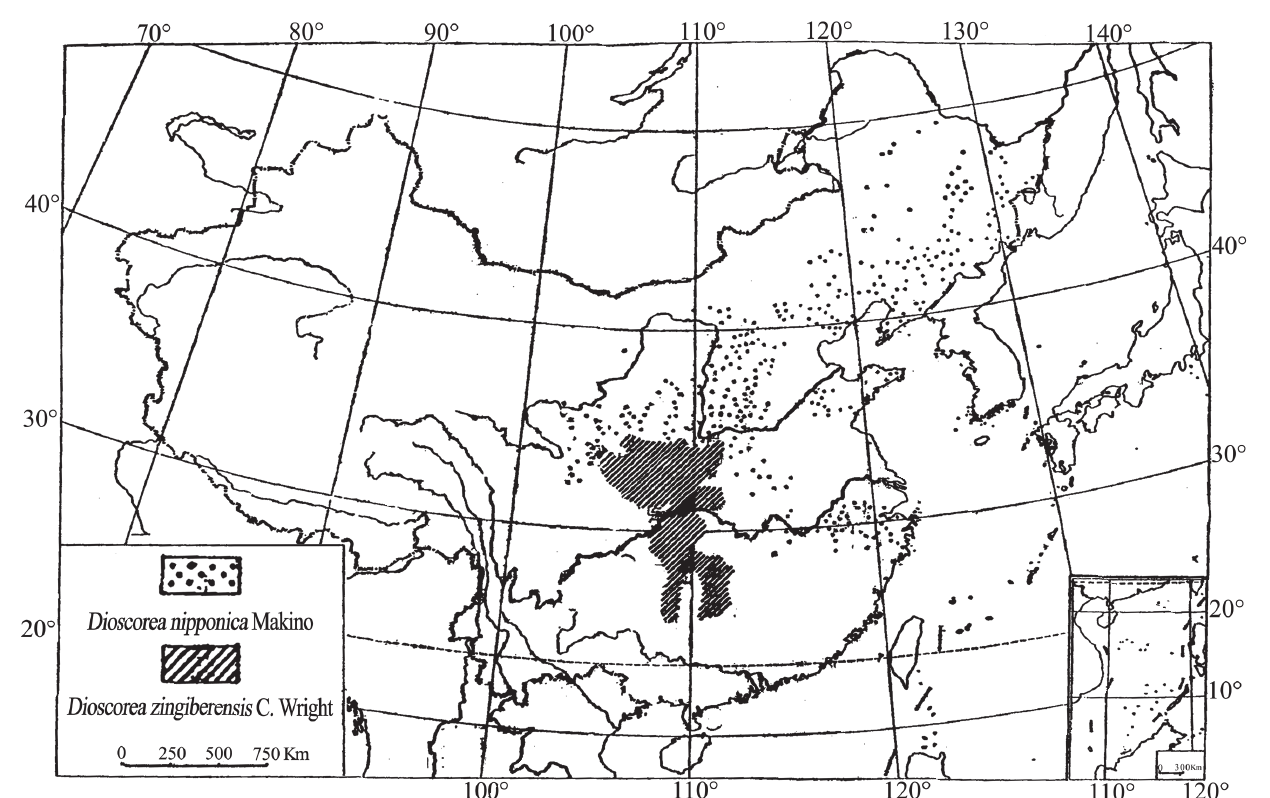
Fig. 1: Natural distribution of Dioscorea zingiberensis C. H. Wright and Dioscorea nipponica Makino in China. zhai county, where is the north of Shanxi Province. Similar to Pang- quangou Nature Reserve, Luyashan belongs to the warm temperate continental mountain climate. About 50% of this region is covered by forest dominated by tree species similar to Pangquangou, such